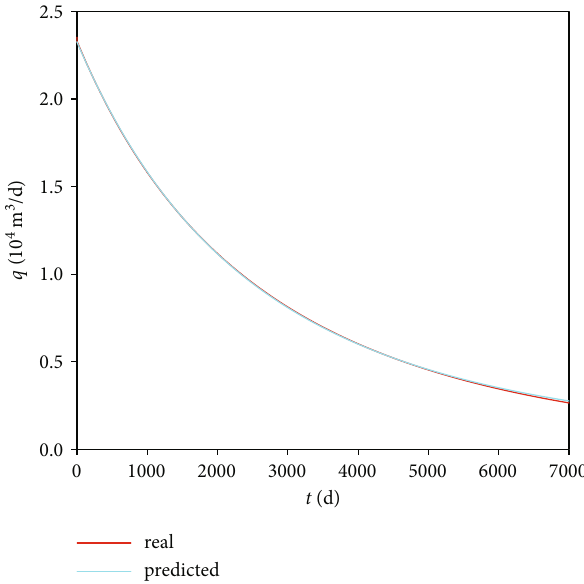
) for Case j Figure 11: The real q pro fi le and the predicted pro fi le by the hyperbolic decline model for Case 1-2.